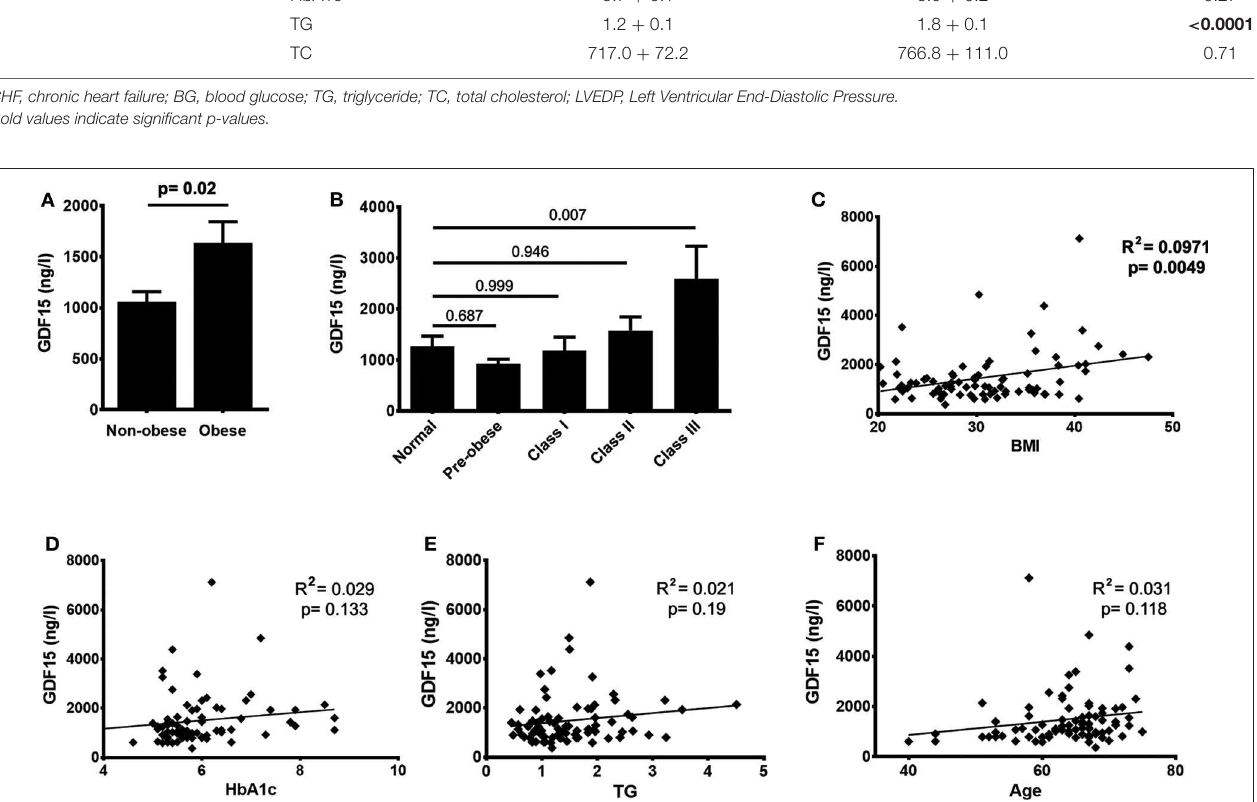
not shown). GDF15 also significantly correlated with BMI ( R 2 = 0.097, Figure 1C ). However, GDF15 expression did not appear to correlate with nutrient-related abnormalities, such as hyperglycemia (defined by HbA1c and RBG, Figure 1D ), hyperlipidemia (defined by TG and TC, Figure 1E ) or age ( Figure 1F ). GDF15 more than any other factors were higher amongst obese patients, providing an opportunity to be a salient indicator associated with obesity-related